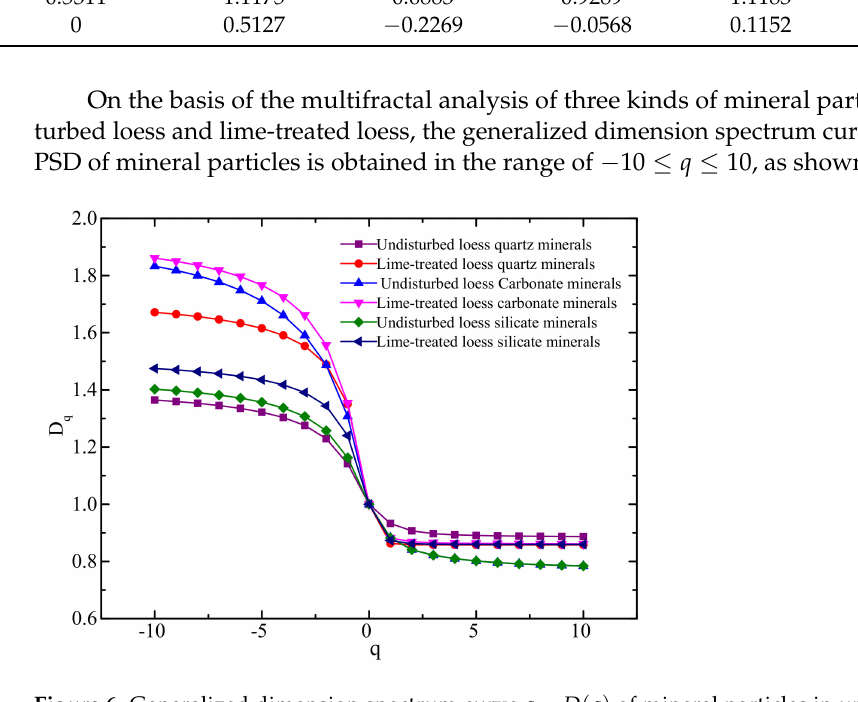
Figure 6. Generalized dimension spectrum curve q − D ( q ) of mineral particles in undisturbed loess and lime-treated